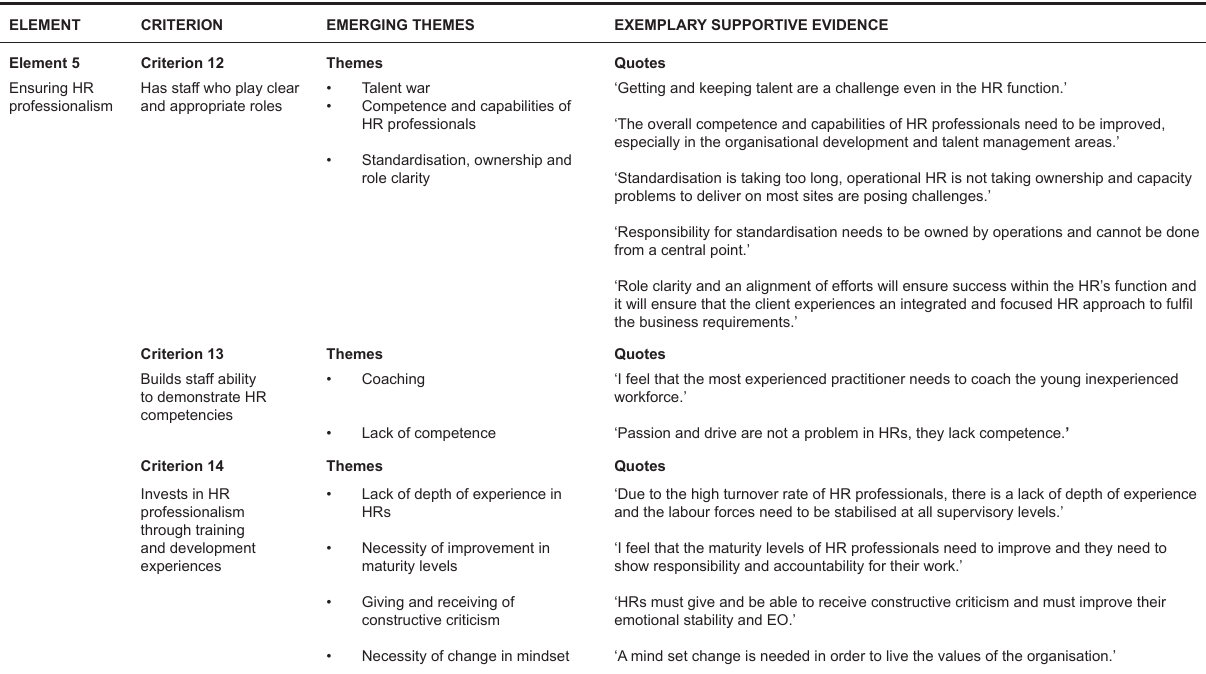
TABLE 6 Emerging themes pertaining to Element 5: Ensuring HR